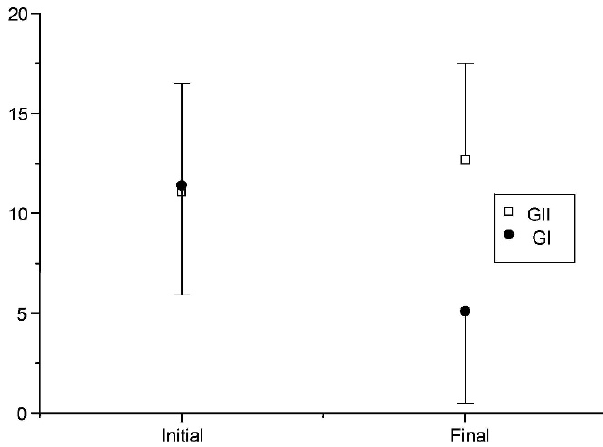
Figure 3 - The mean and standard deviation of ICIQ - SF before and after the intervention in the treatment (GI) and sham (GII) groups. Mean: 11.38 initial and 5.07 final in GI and 11.07 initial and 12.71 final in GII ( p =0.0003).